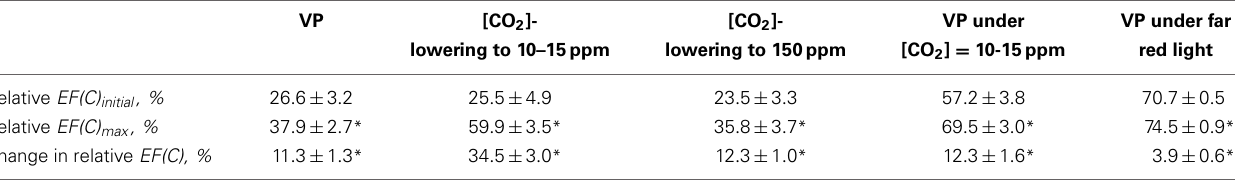
Table 4 | Relative cyclic electron flow and changes induced by VP and [CO 2